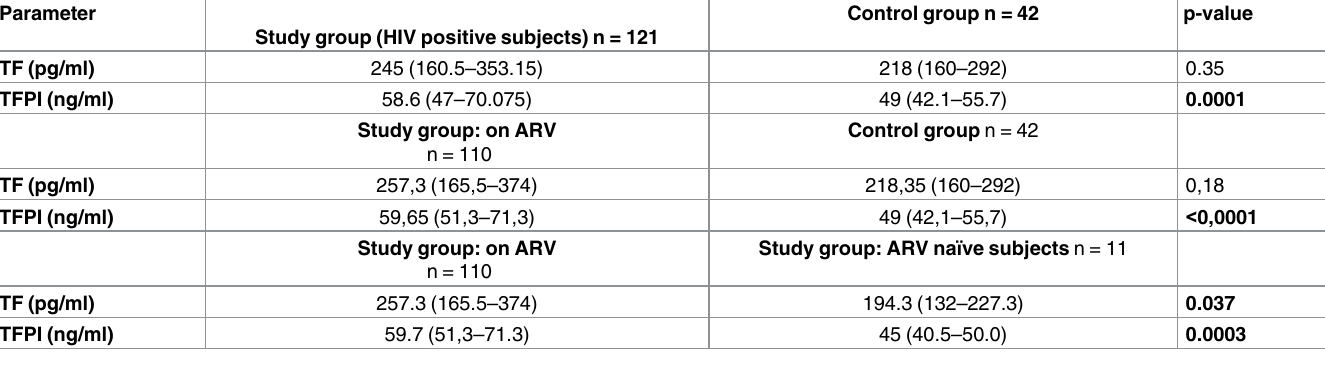
Table 2. Comparisons of plasma levels of TF and TFPI between subjects from the study and control group (Mann-Whitney test).